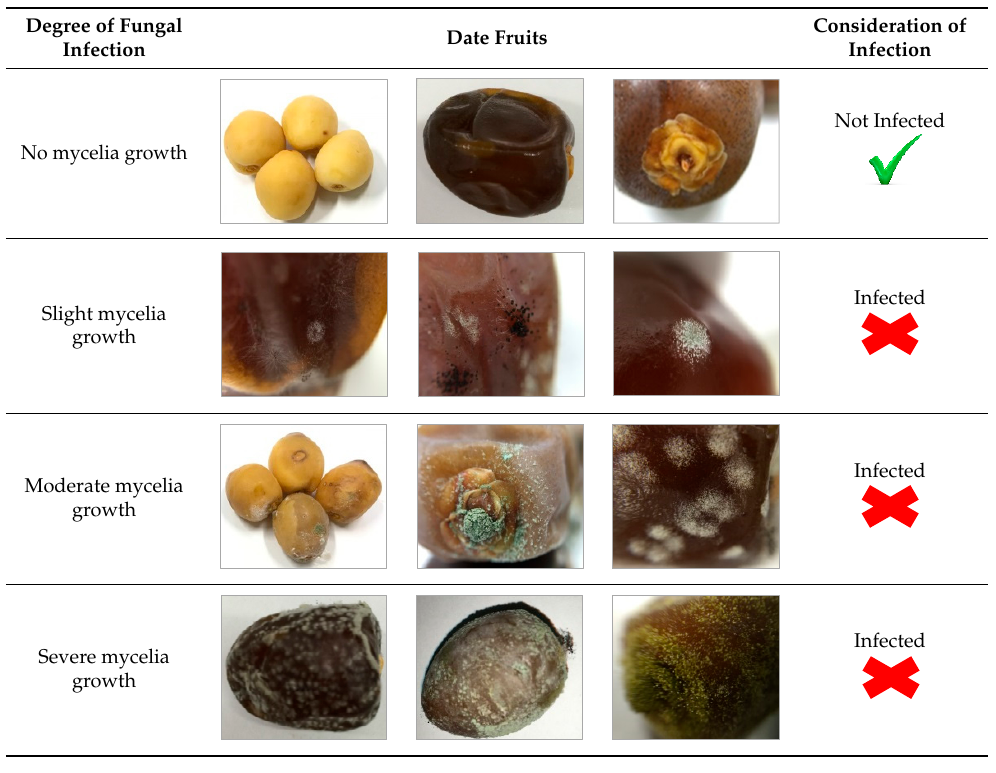
Table 1. Infected/non-infected dates by fungi show the guideline for determining the shelf life of dates after treatment.